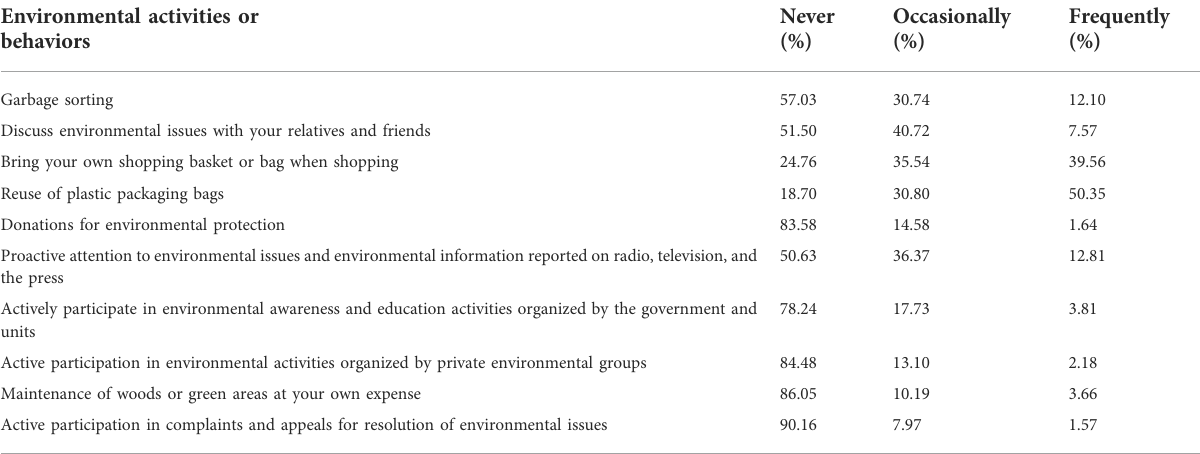
TABLE 1 Statistics of residents ’ pro-environmental behaviors